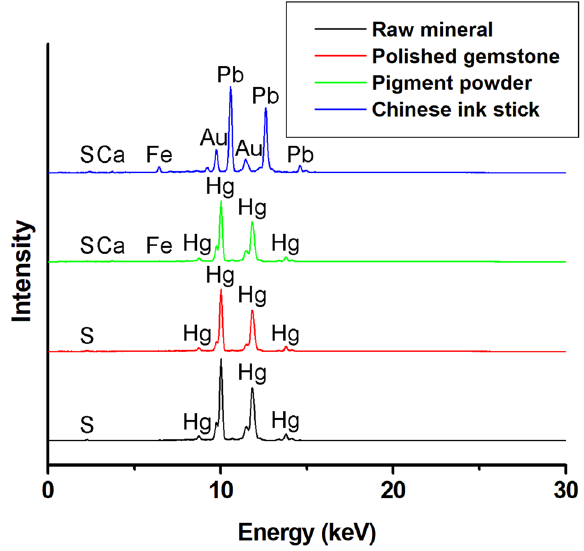
Fig. 7 Portable XRF spectra for the four